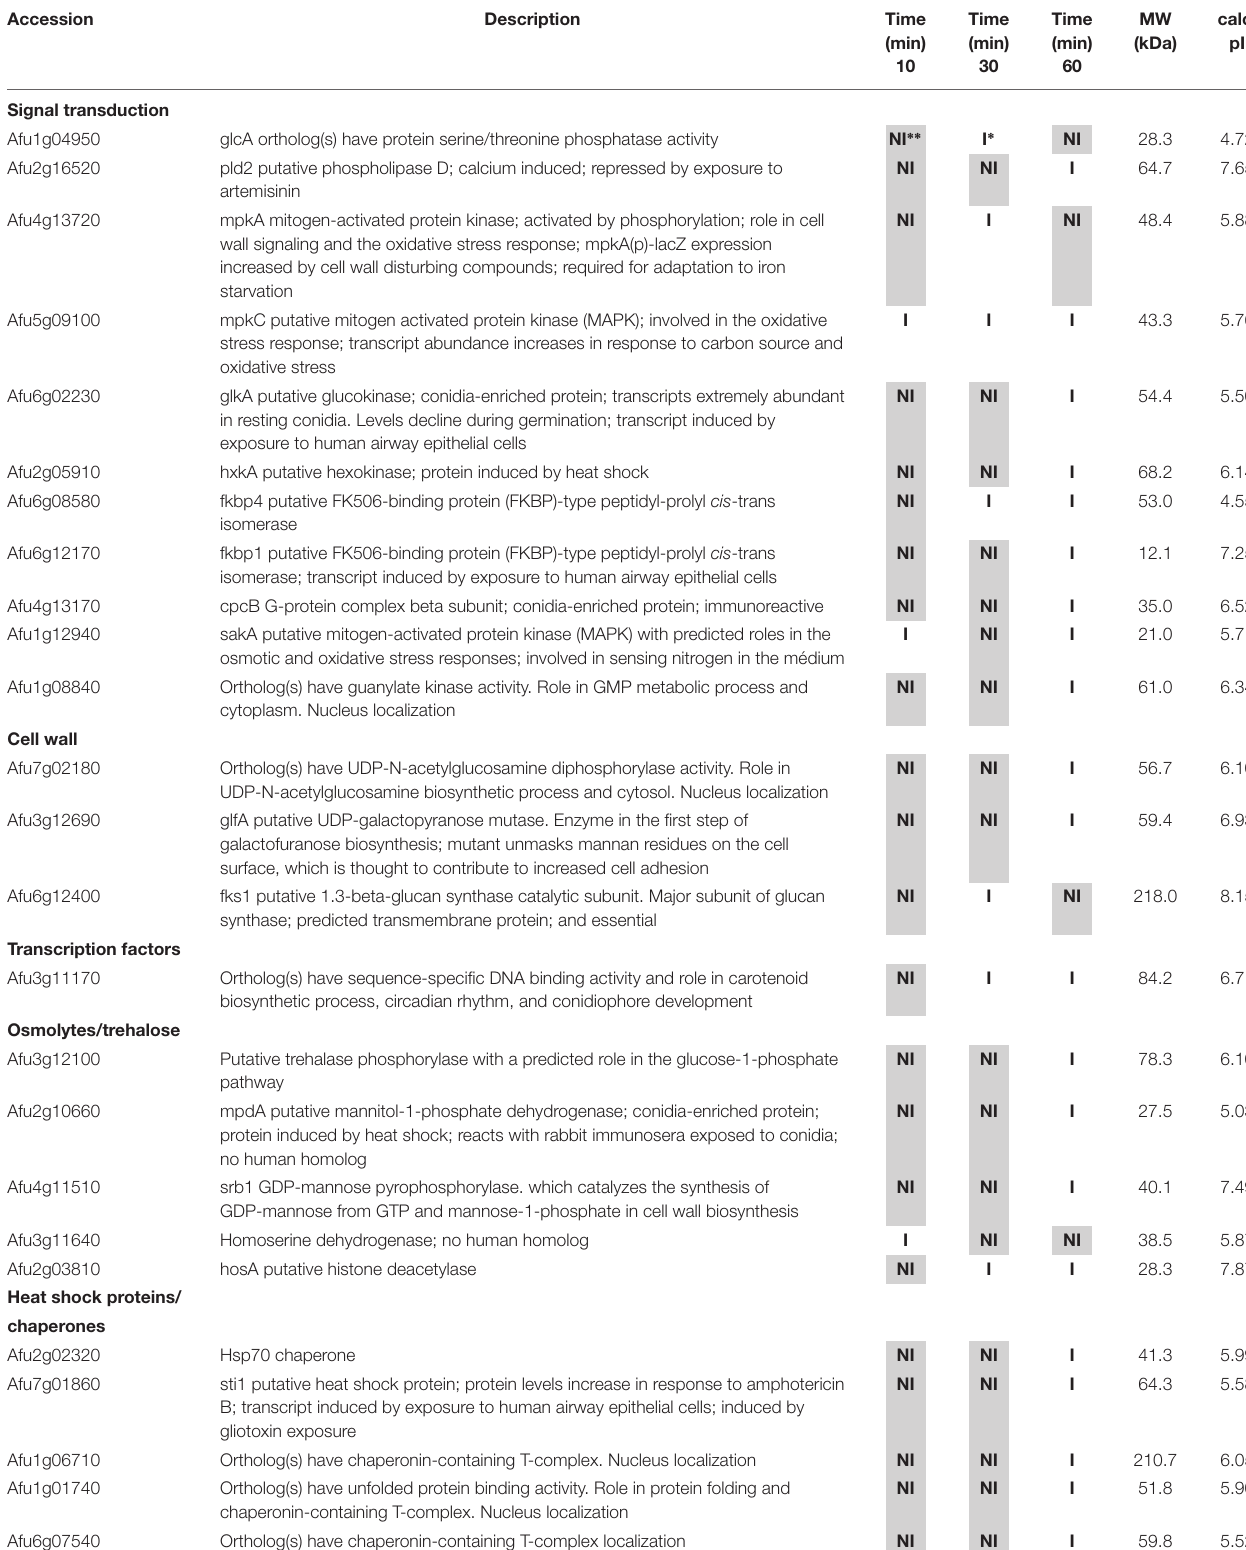
TABLE 2 | Selected proteins interacting with MpkC::GFP identified during osmotic stress. Accession